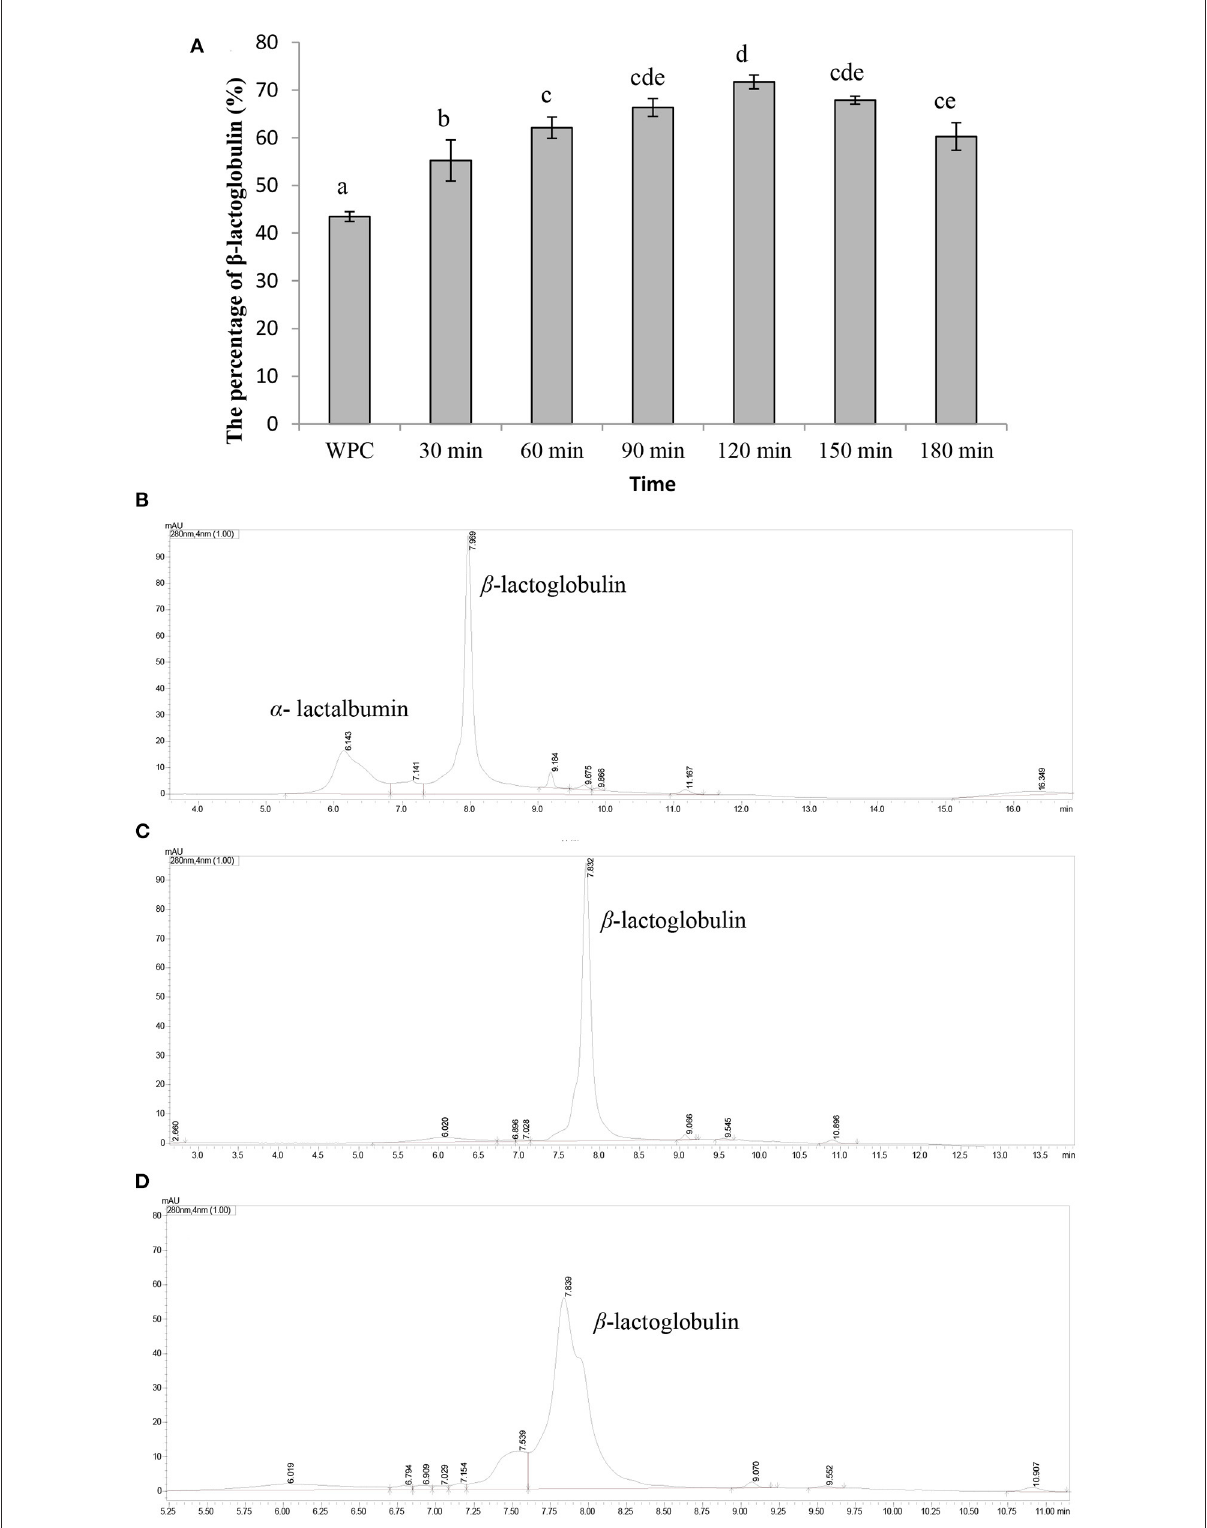
FIGURE1 Characterization of β -lactoglobulin enriched. Data are expressed as the mean ± SD ( n = 3), and ANOVA was performed to evaluate the difference, followed by the Duncan post-hoc test. (A) The percentage of β -lactoglobulin. Different letters indicate a significant difference ( p < 0.05). (B) The UPLC spectra of whey protein. (C) The UPLC spectrum of whey protein hydrolyzed by acid protease for 120min. (D) The UPLC spectrum of whey protein hydrolyzed by acid protease for 180